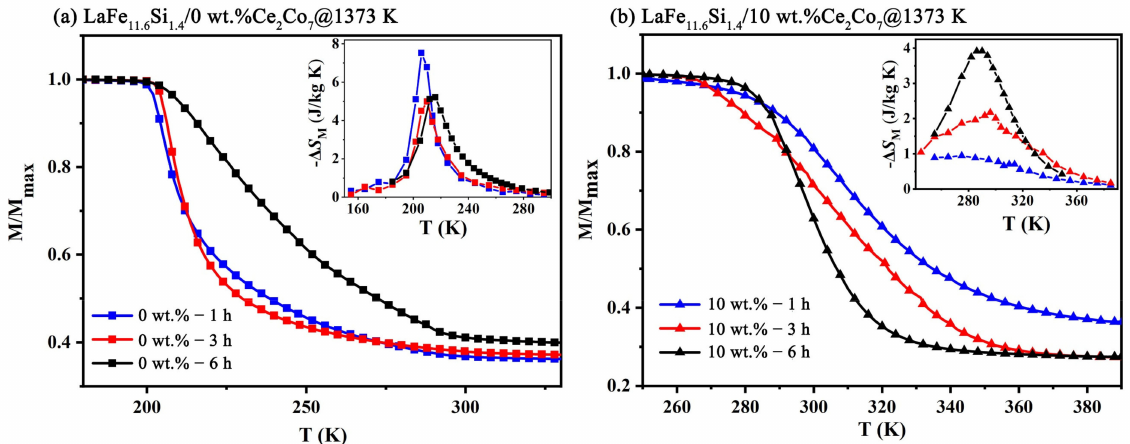
Figure 8. Normalized M / M max – T curves of the binder-free and 10 wt.% Ce 2 Co 7 binder composites sintered at 1373 K for 1~6 h upon cooling under an applied field of 0.05 T. Insets in panels ( a , b ) are ( − ∆ S M ) vs. T curves for the composites with and without Ce 2 Co 7 binder under a magnetic field change of 0–2 T,